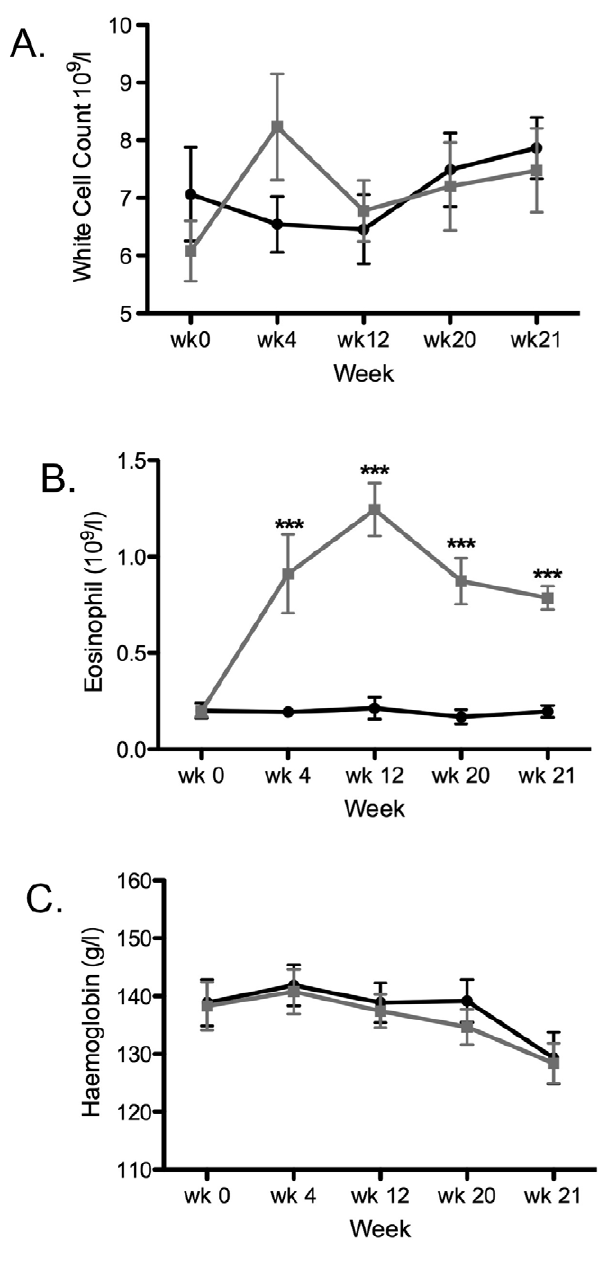
Figure 5. Blood cell and marker levels. (A) white cell, (B) eosinophil (C) hemoglobin. Control group is indicated by black circles, hookworm group by grey squares, values are mean + / 2 SEM. Data was analyzed by two-way ANOVA: significant effects of time and interaction was shown in (B), and post-hoc one-way ANOVA on each group showed the differences between timepoints as